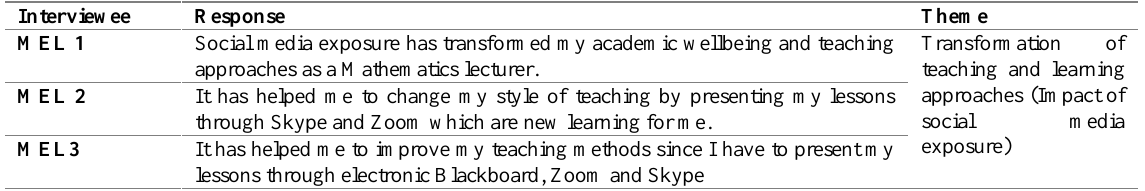
Table 2: Question 2 - What is the impact of students’ exposure to social media on your experiences of teaching Mathematics? Interviewee